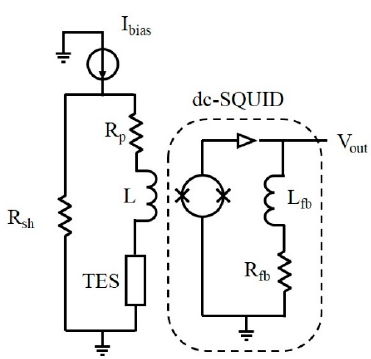
Figure 2. Scheme of the electronic bias circuit with the TES, the shunt resistance ( R sh ), the parasitic resistance ( R p ), and the read-out line exploiting an array of dc-SQUID as current amplifier.